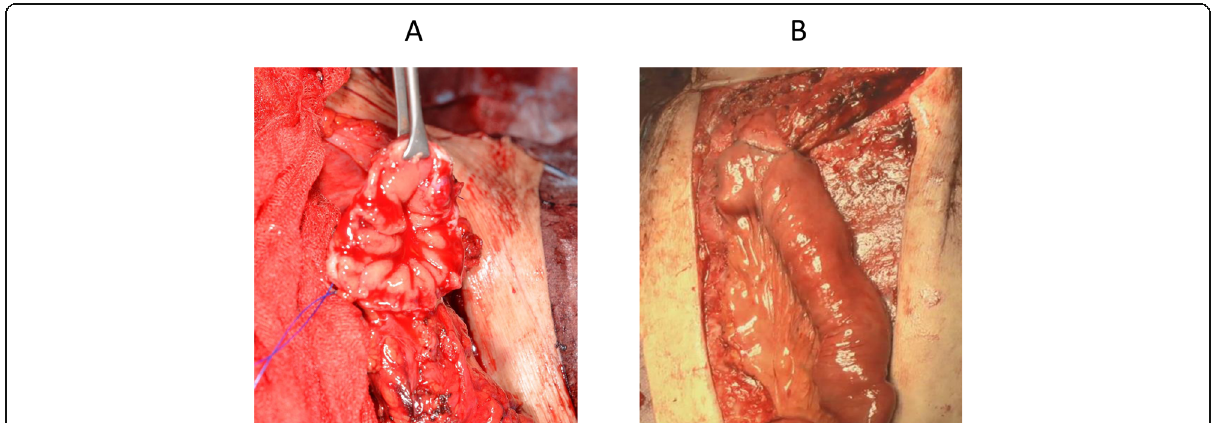
Fig. 4 a The color of the cutting edge of the gastric tube is not pale, and bleeding is confirmed. b The completed anastomosis of the remnant gastric tube and jejunum